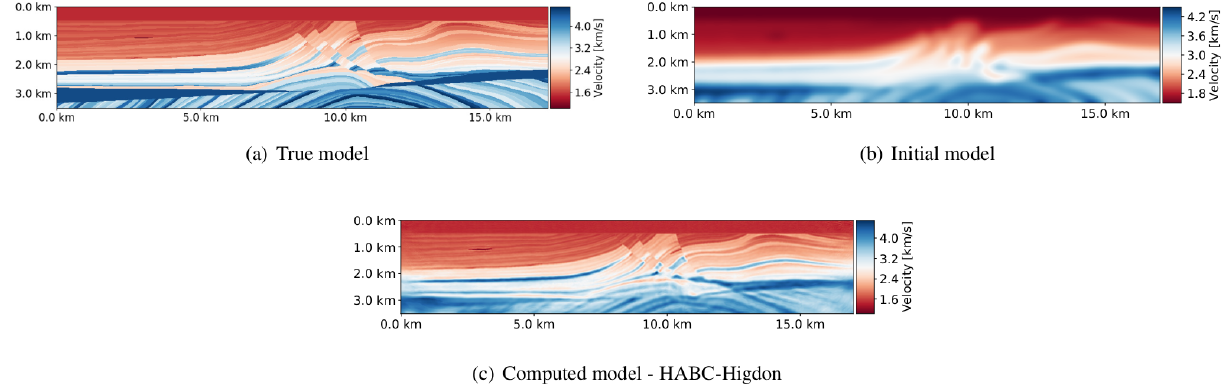
Figure 16. Velocity model comparisons.